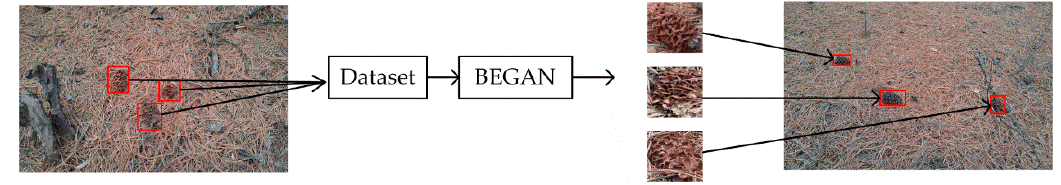
Figure 13. Image generated by BEGAN.